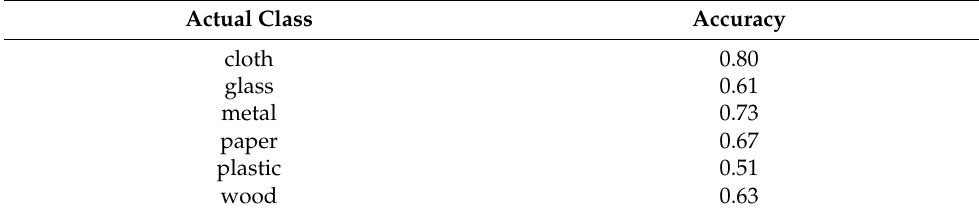
Table 6. Accuracy for each material class.